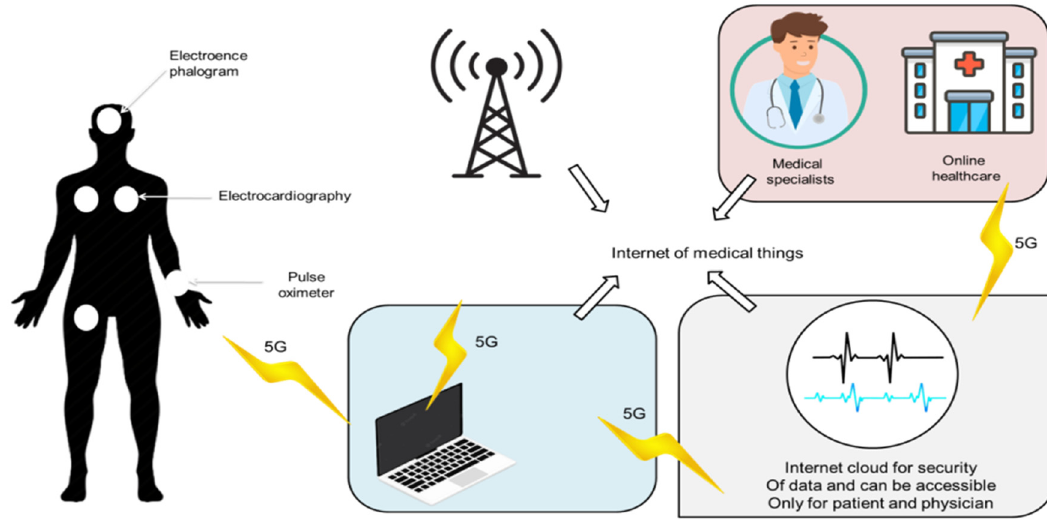
Figure 1: IoMT in the healthcare